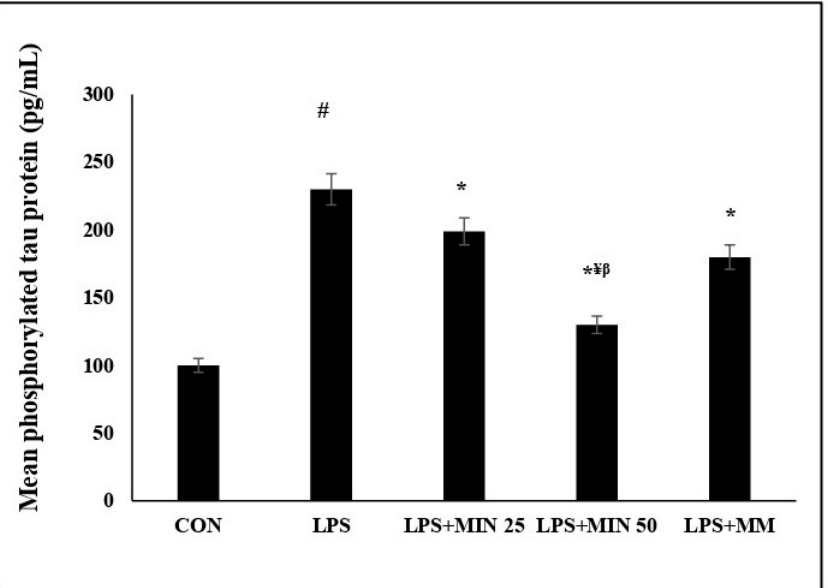
Figure 5. Effects of minocycline on the mean phosphorylated tau protein level in the mPFC. One-way ANOVA test followed by Bonferroni post hoc test. Values are expressed as mean ± SEM. n =10. (F (1, 36) = 25.2 and # p < 0.05) versus control group; (F (1, 36) = 4.59; * p < 0.05) versus LPS group, (F (1, 36) =7.39; ¥ p < 0.05) versus MIN 25, (F (1, 36) = 12.79; β p < 0.05) versus MM.